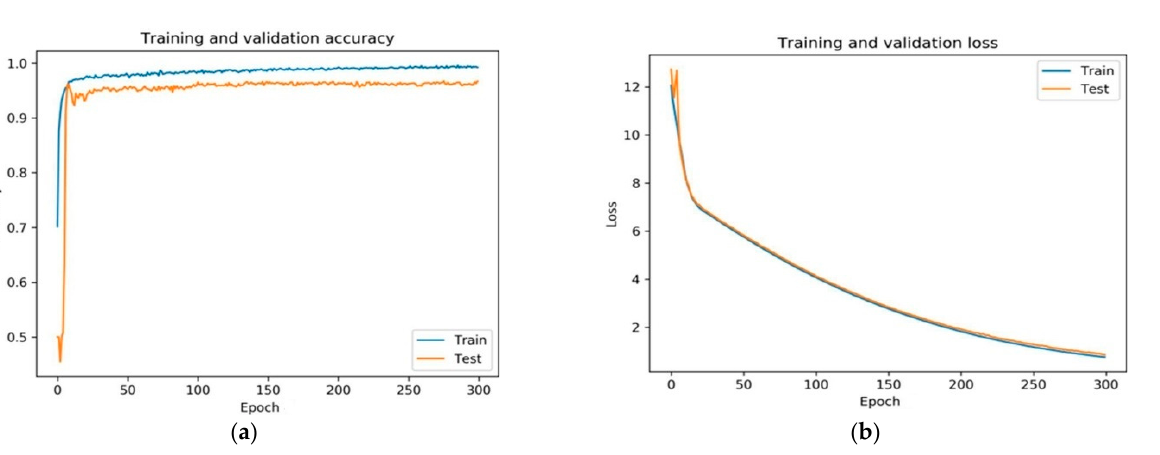
shows the training and validation loss of the proposed fine-tuned VGGNet framework.